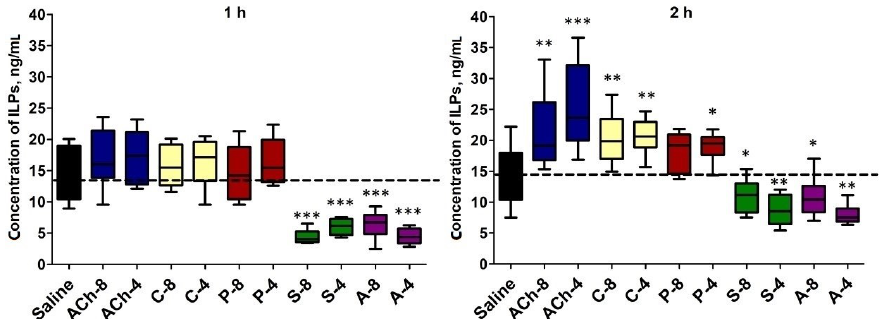
Figure 5. Concentration of ILPs (ng/mL) in the hemolymph of T. molitor larvae injected with acetylcholine (ACh), carbachol (C), pilocarpine (P), atropine (A), and scopolamine (S) at concentrations of 10 − 8 (X-8) and 10 − 4 (X-4) M, respectively, for each compound. The samples of hemolymph were collected after 1 and 2 h of incubation. The control larvae were treated with saline. The data are shown as the mean ± SD from 10 to 14 repetitions. Statistically significant differences from the control values are indicated by asterisks (Student’s t -test), where * p ≤ 0.05, ** p ≤ 0.01, and *** p ≤